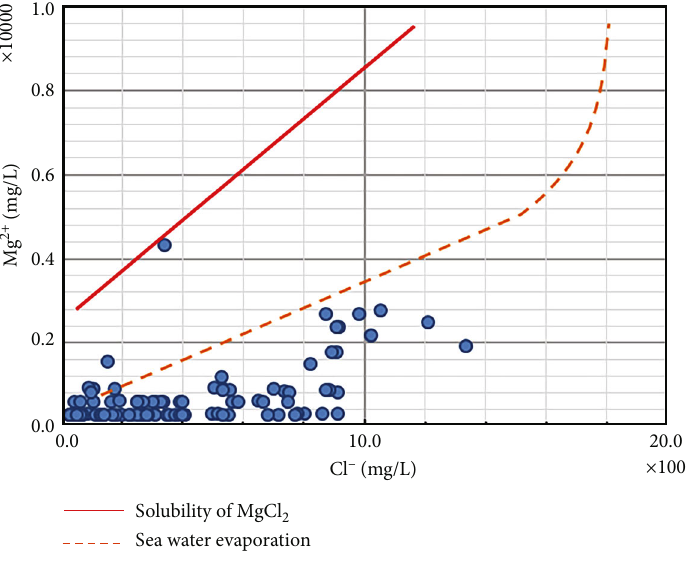
Figure 8: Comparison of Mg 2+ vs Cl − crossdiagram and theoretical evaporative dissolution